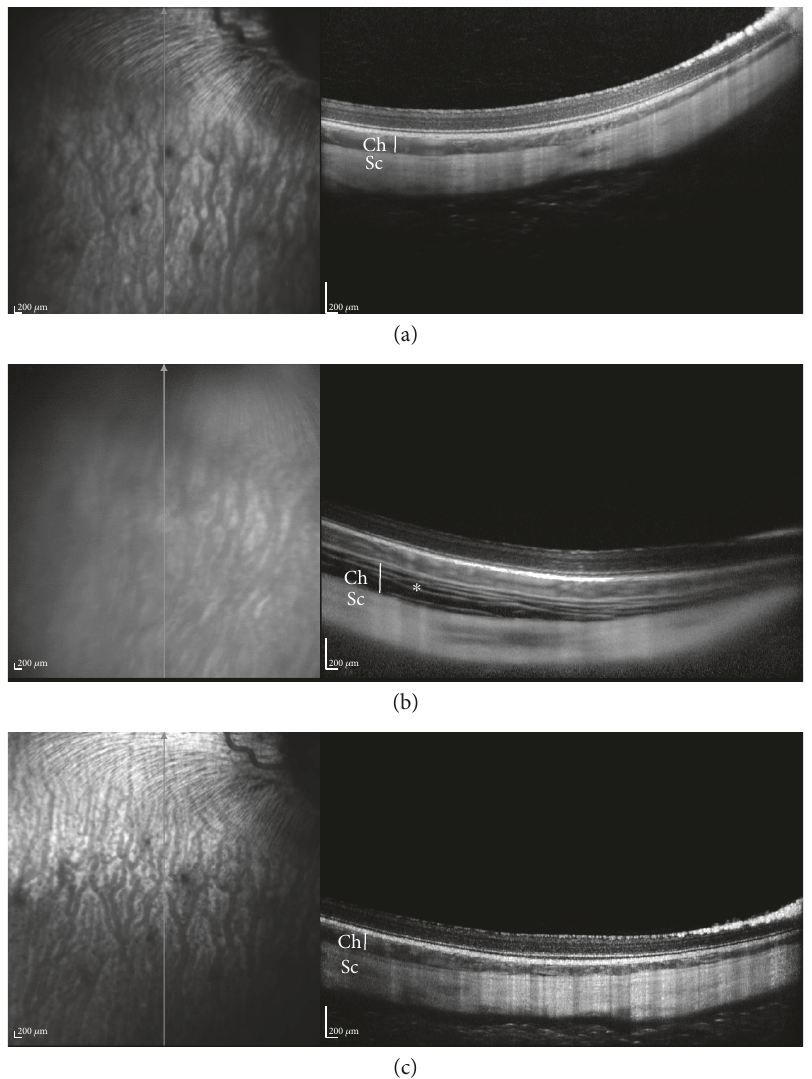
Figure 6: SD-OCT imaging reveals no retinal detachment or choroidal hemorrhages following hBMSC transplantation. SD-OCT images of rabbit eyes before (a), 1 hour (b), and 10 weeks (c) following hBMSC transplantation. Choroidal “ stretching ” (highlighted with an asterisk) is evident 1 hour following cell transplantation. Choroidal thickness in each time point is highlighted with a white vertical line. Ch: choroid; Sc: